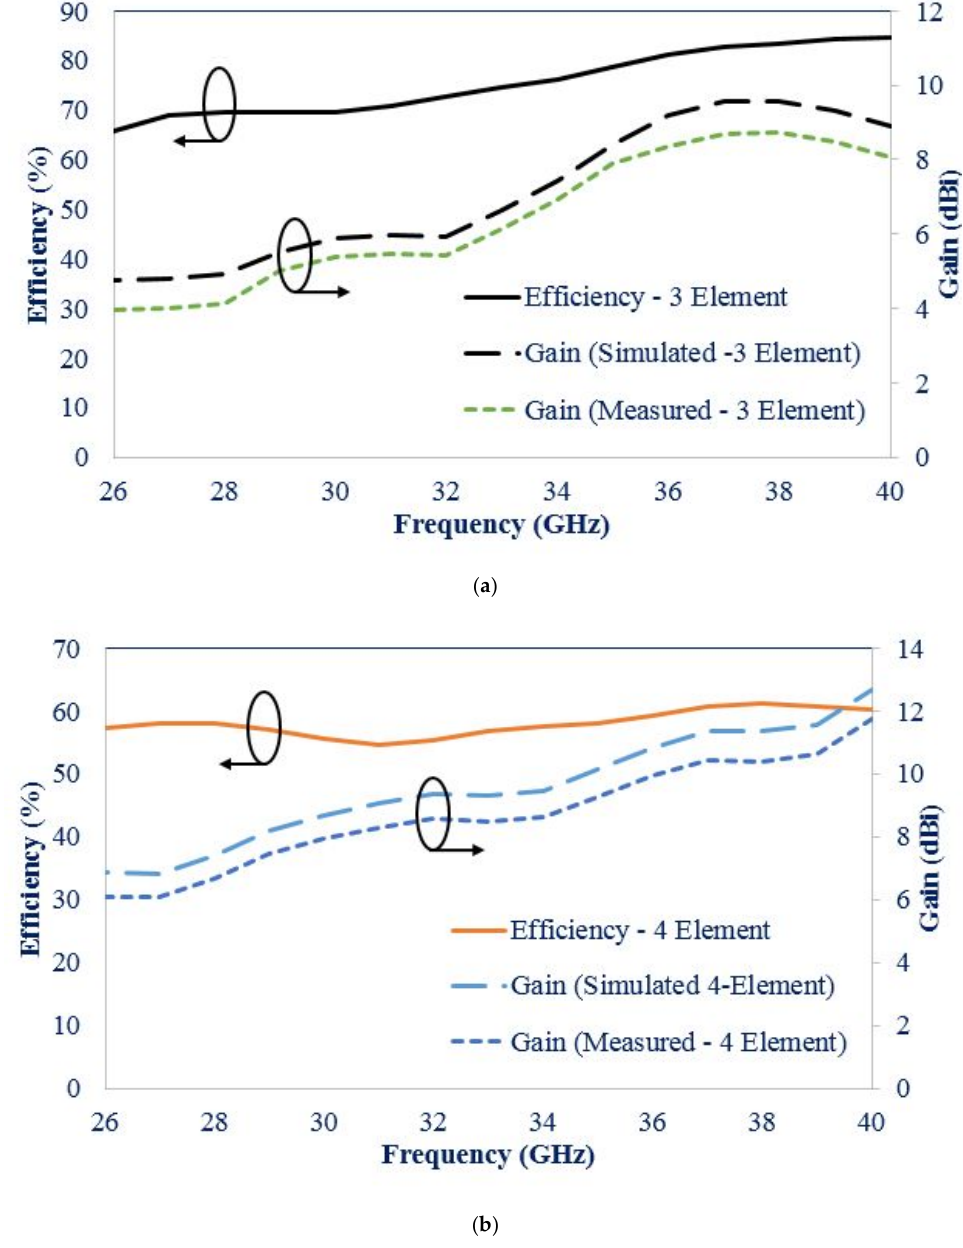
Figure 19. Efficiency and gain of the proposed ( a ) three-element and ( b ) four-element MIMO an-